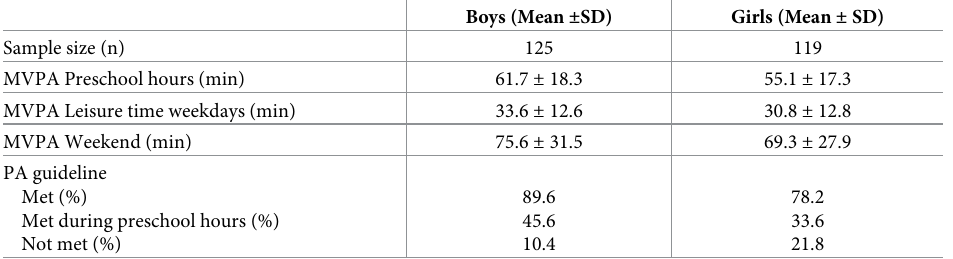
Table 1. Descriptive characteristics of children (age 4–6): min in MVPA and fulfilment of the global PA